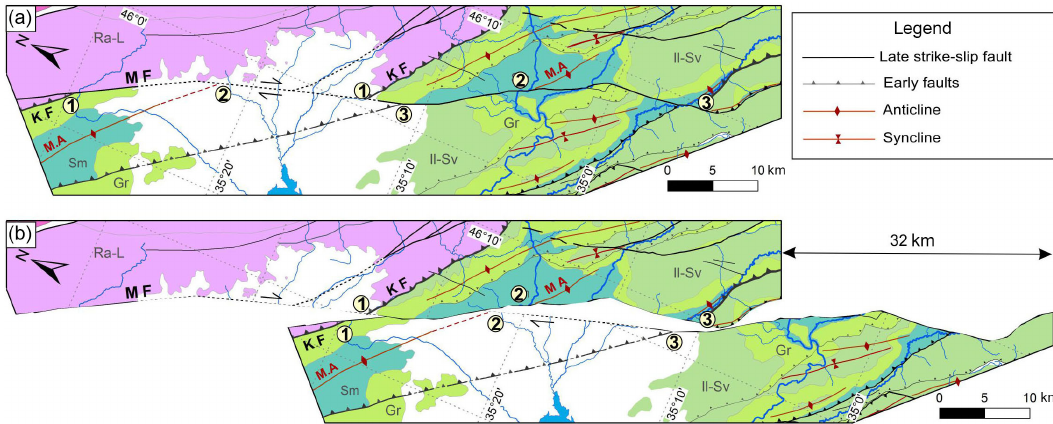
Figure 13. Restoration of about 32km dextrally offset on the early structures by the Marekhil Fault (MF). The numbers in circles show locations of the older structures such as the Kermanshah Fault (KF), Marekhil Anticline (MA) and a thrust fault on both walls of the Marekhil Fault; (a) before restoration; (b) after